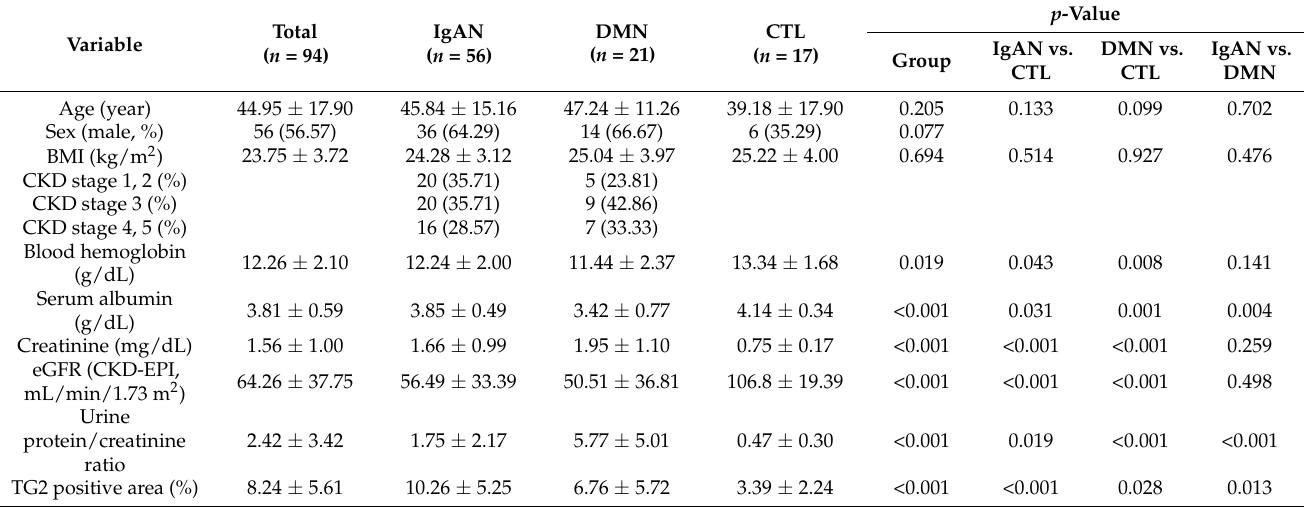
Table 2. Characteristics of patients with TG2 expression in kidney